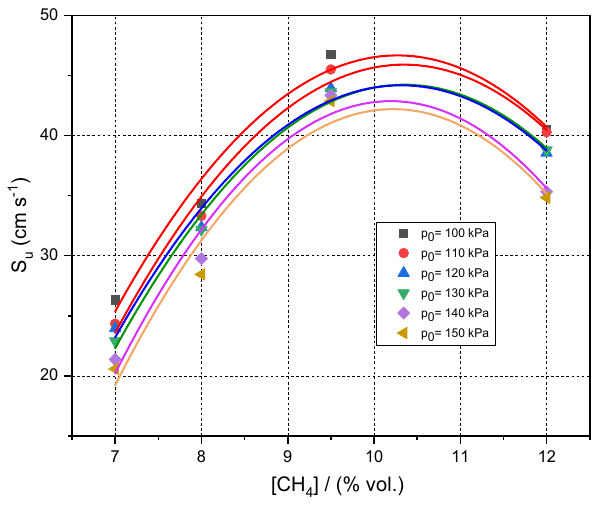
Figure 4. Normal burning velocities of CH 4 –air at various initial pressures; experimental data. A comparison between the normal burning velocities of methane–air at ambient initial and the normal burning velocities in the presence of a radioactive source is plotted in Figure 5. The data were fitted by second–order polynomials. The burning velocities of methane–air in the presence of the Cobalt source were up to 4% lower than in